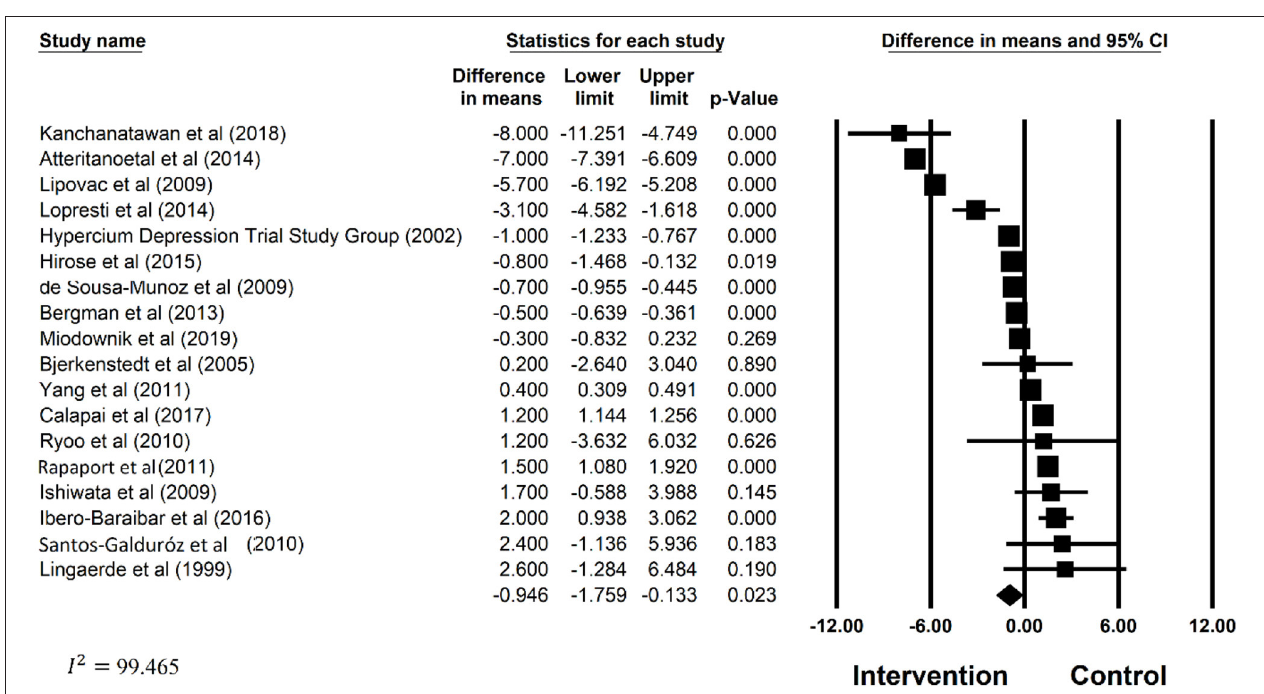
FIGURE 2 | Forest plots of the effect polyphenol supplementation on